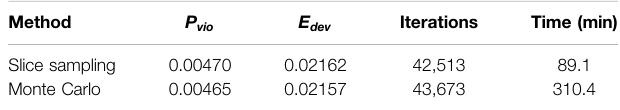
TABLE 1 | Comparison of slice sampling and Monte Carlo.